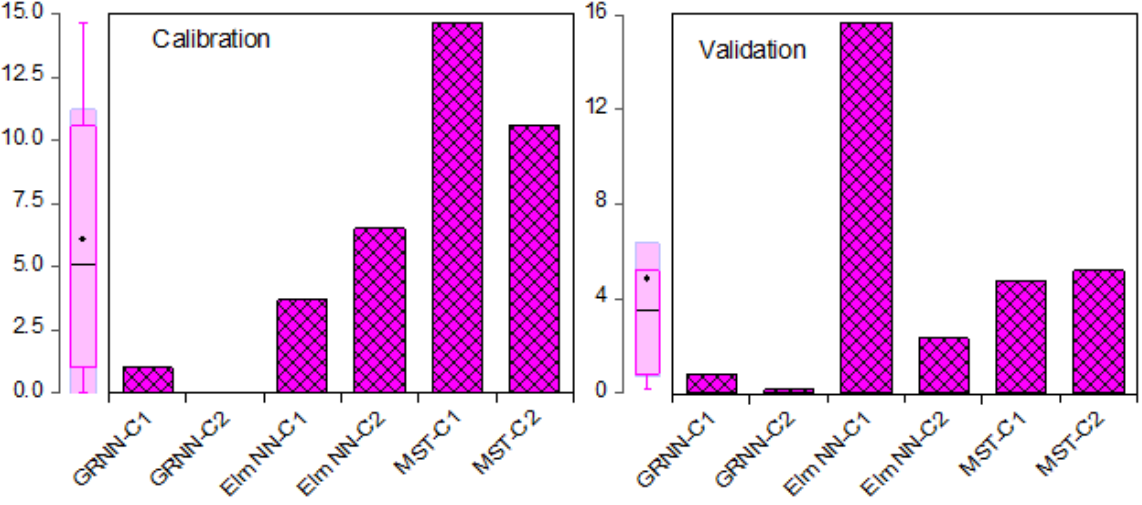
Figure 7. Comparative RMSE performance of the GRNN, Elm NN, and MST techniques for the Cr concentration (mg/kg) estimation in both calibration and validation phases.